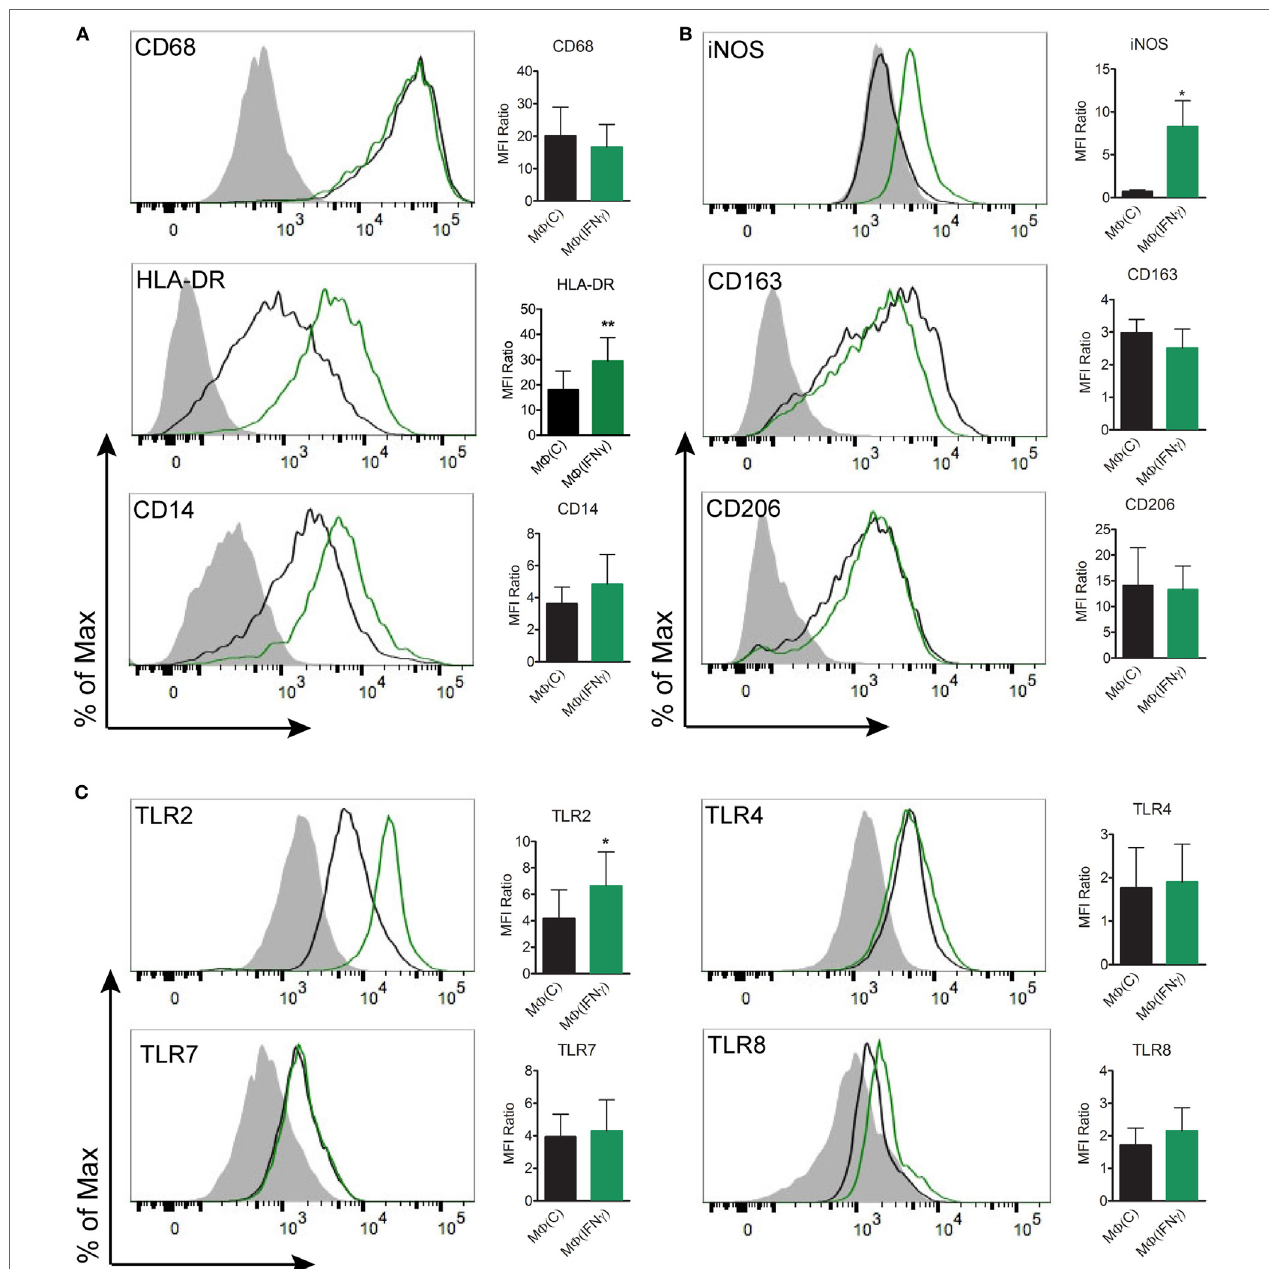
FigUre 3 | Flow cytometric analysis of macrophage immunophenotypic profile. Monocyte-derived macrophages were generated from healthy controls by incubating monocytes with M-CSF [M Φ (C)] for 7 days and then a portion of the macrophages were activated with IFN γ [M Φ (IFN γ )] for the remaining 3 days. M Φ (C)s (black) and M Φ (IFN γ )s (green) from the same participant were stained for (a) macrophage markers: CD68 IC , HLA-DR, CD14, (B) phenotypic markers: iNOS IC , CD163, CD206, and (c) Toll-like receptors: TLR2, TLR4, TLR7 IC , TLR8 IC ; the filled gray histograms indicate the isotype control. Histograms are representative of a minimum of four independent experiments that were used to quantify the mean fluorescence index (MFI) ratio ± the SD as described under Section “Materials and Methods.” Paired Student’s t -tests (Wilcoxon test) was used to determine statistical significance between the two macrophage phenotypes, * p -value of < 0.05, ** p -value of < 0.01. IC, intracellular